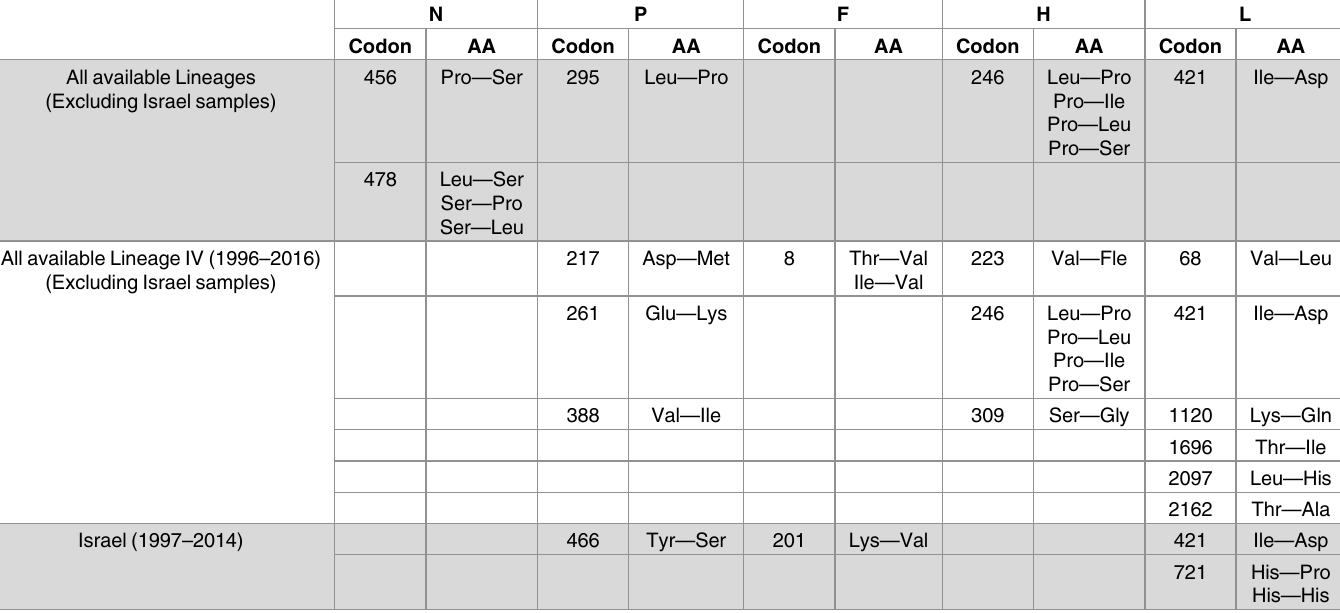
Table 4. Significant amino acid changes identified in PPRV lineage